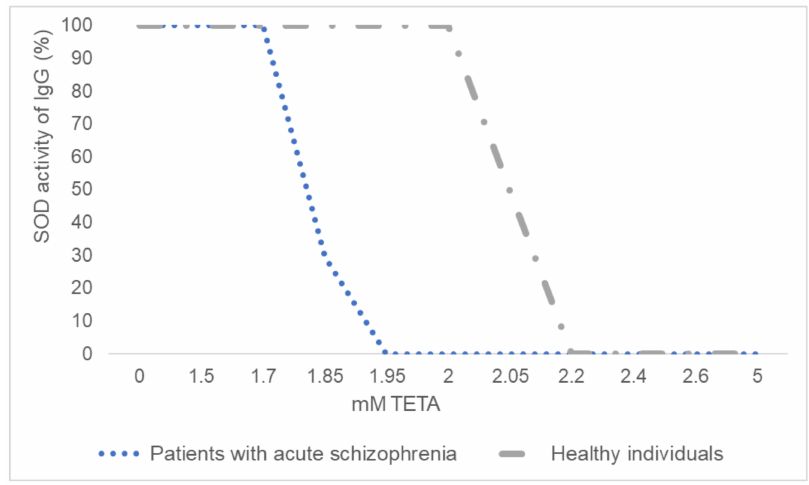
Figure 2. The dependence SOD activity of IgGs on the triethylenetetramine (TETA) concentration. The results are presented as percentages. SOD activity of IgGs without inhibitor is taken as 100%.